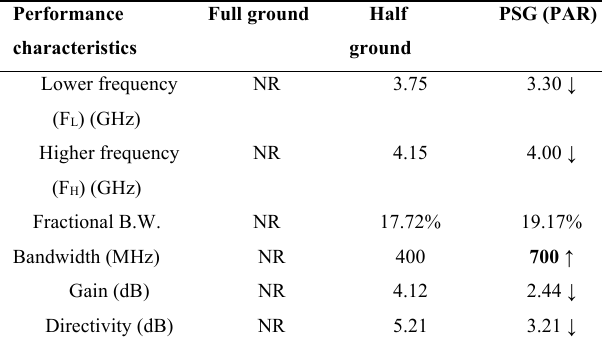
TABLE III. Output performance characteristics for the three